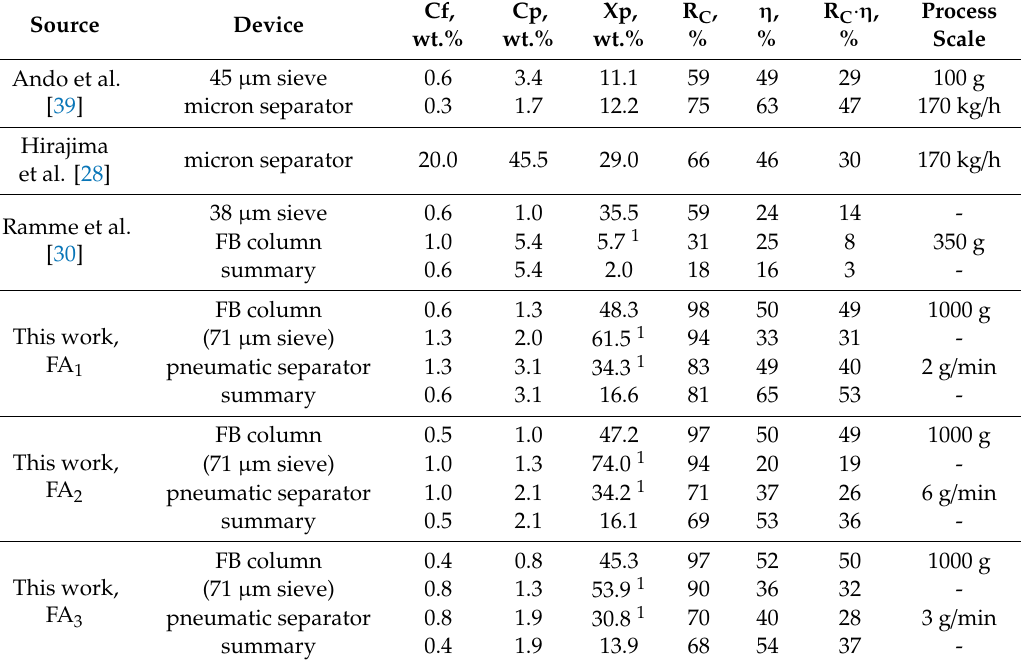
Table 7. Comparison of the proposed MS recovery methods with the data obtained from the literature.